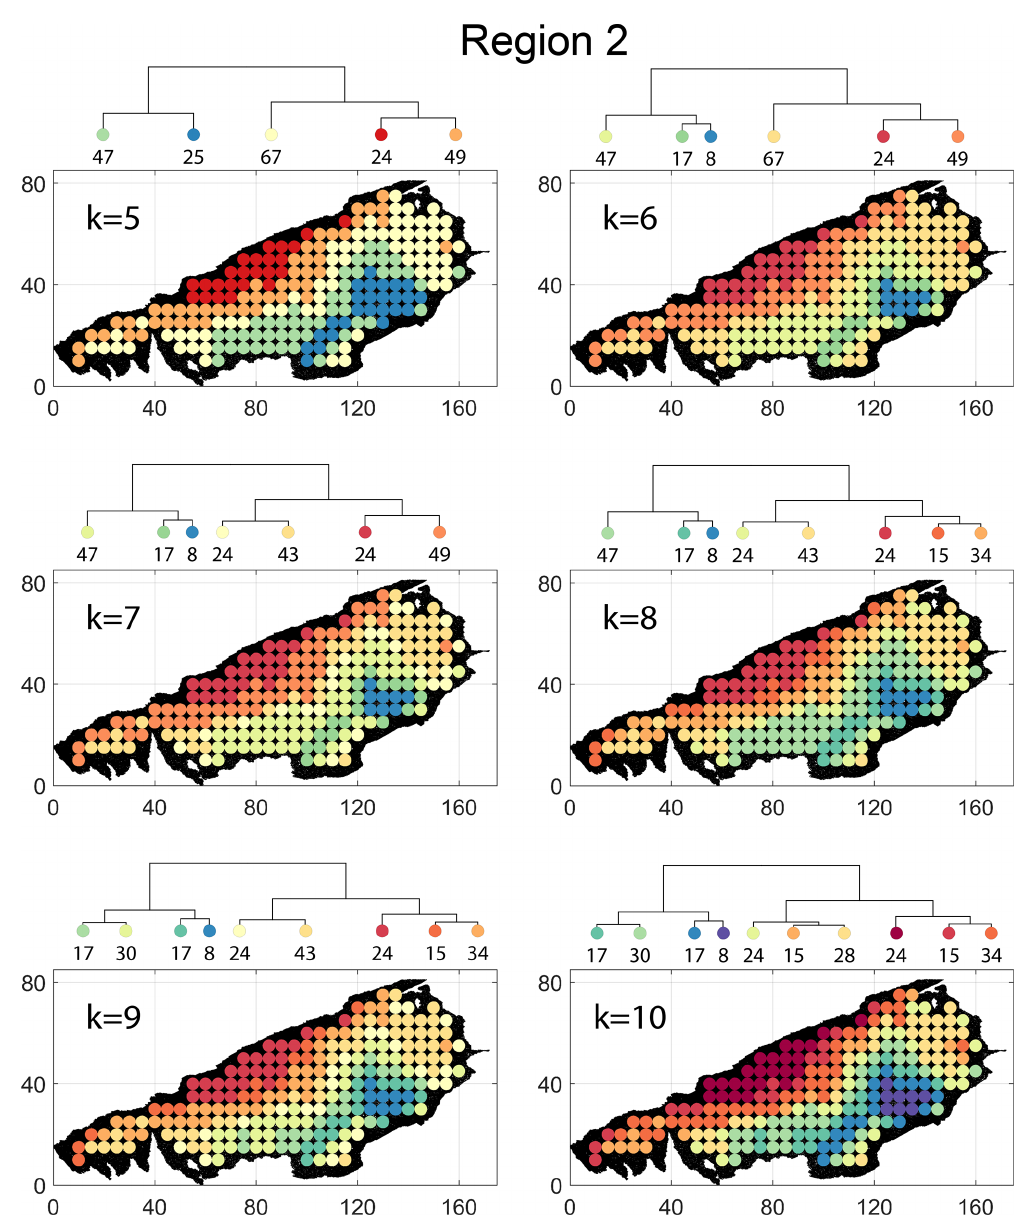
Figure B8. Variation in cluster boundaries for “ k ” clusters in Region 2 using portrait